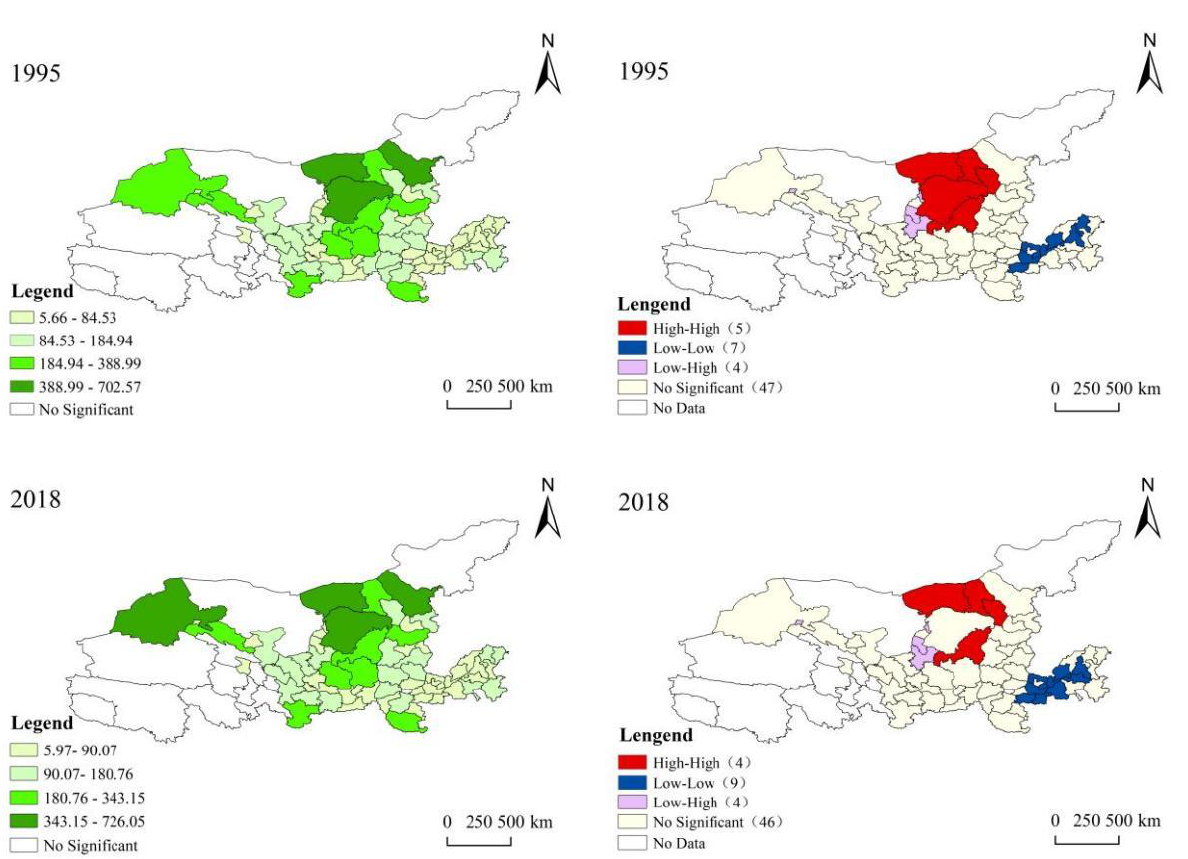
Figure 5. Spatial distribution of urban ecosystem service value in the Yellow River Basin (China) in 1995 and 2018.